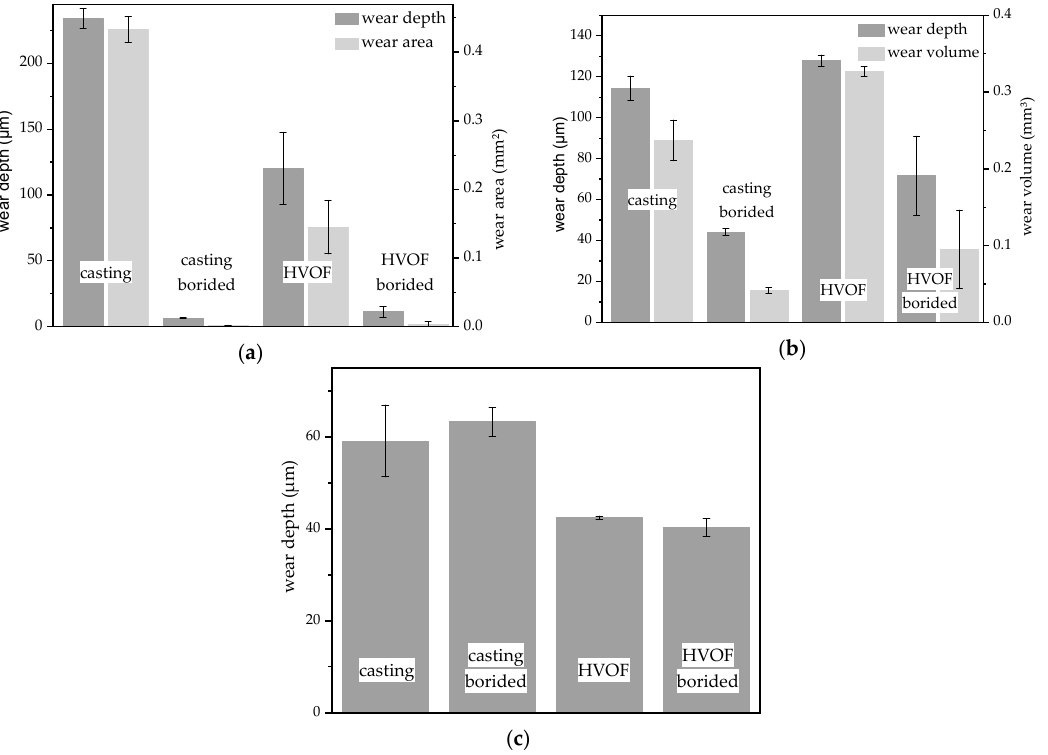
Figure 5. Results of wear investigations of CrFeCoNi casting and HVOF coating in untreated and borided state: ( a ) ball-on-disk test; ( b ) reciprocating wear test; and ( c ) scratch test.